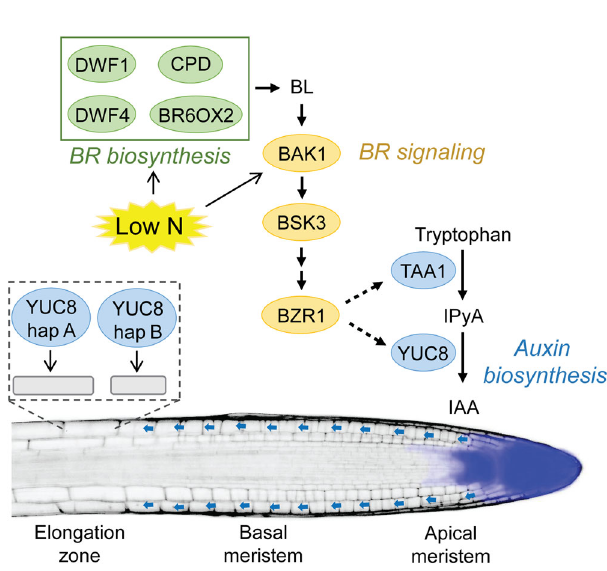
Fig. 6 Model for low N-induced local auxin biosynthesis downstream of BR signaling to stimulate LR elongation. Low external N availability that results in mild N de fi ciency induces the expression of the BR co-receptor BAK1 (Jia et al. 24 ) and several genes involved in BR biosynthesis (Jia et al. 25 ). Downstream of BR signaling, an auxin biosynthesis module composed of TAA1 and YUC8 together with its homologs YUC5 and YUC7 is induced to generate more IAA in the apical meristem of LRs (blue area in LR). Upon transport to the elongation zone (blue arrows), locally generated IAA enhances cell expansion. Allelic coding variants of YUC8 in natural accessions of A. thaliana determine the extent of the root foraging response to low N by differentially modulating cell elongation (schematic representation within dashed